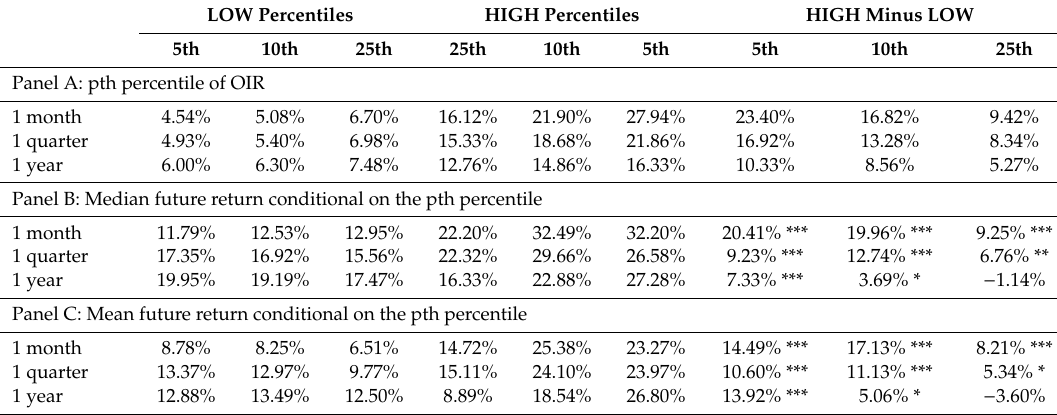
*, ** and *** denotes significance at the 10%, 5% and 1% significance level and refers to the differences in Panels B and C.